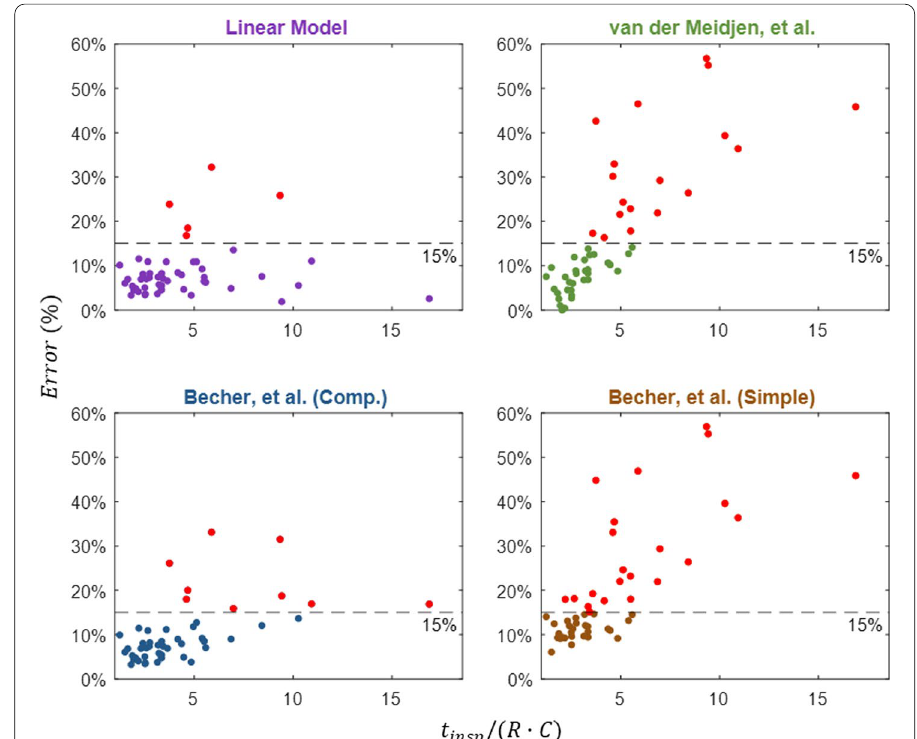
Fig. 3 Percent error (MP ref MP)/MP ref for each of the four equations [2, 3] as a function of the parameter − t insp /( R C ). Calculations that resulted in greater than 15% error are highlighted in ·